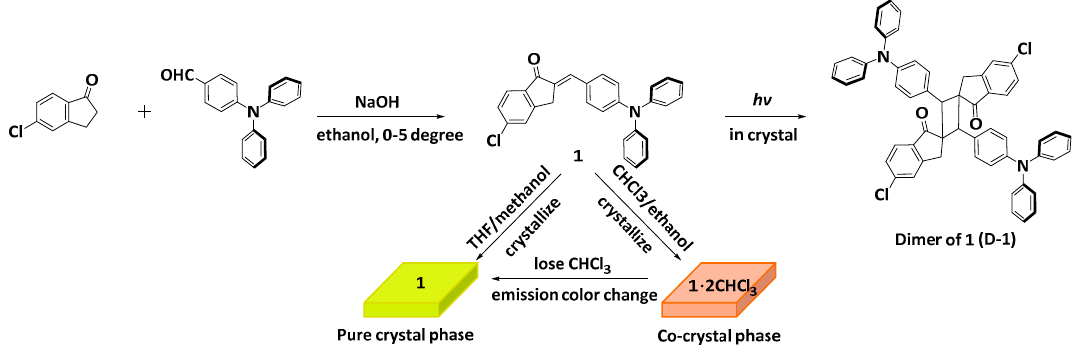
Figure 1. Synthesis, cycloaddition reaction and two different crystal phase of compound 1.